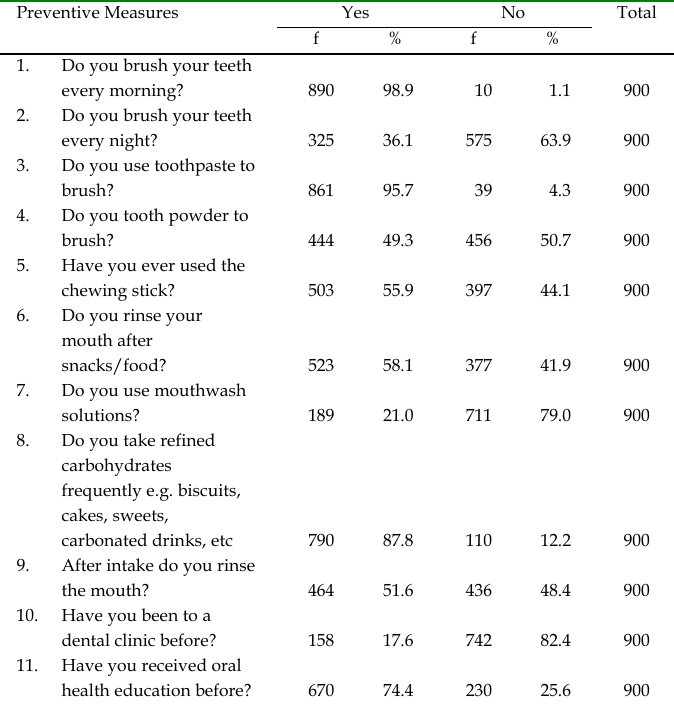
Table 1: Percentage responses on the preventive measures adopted by Senior